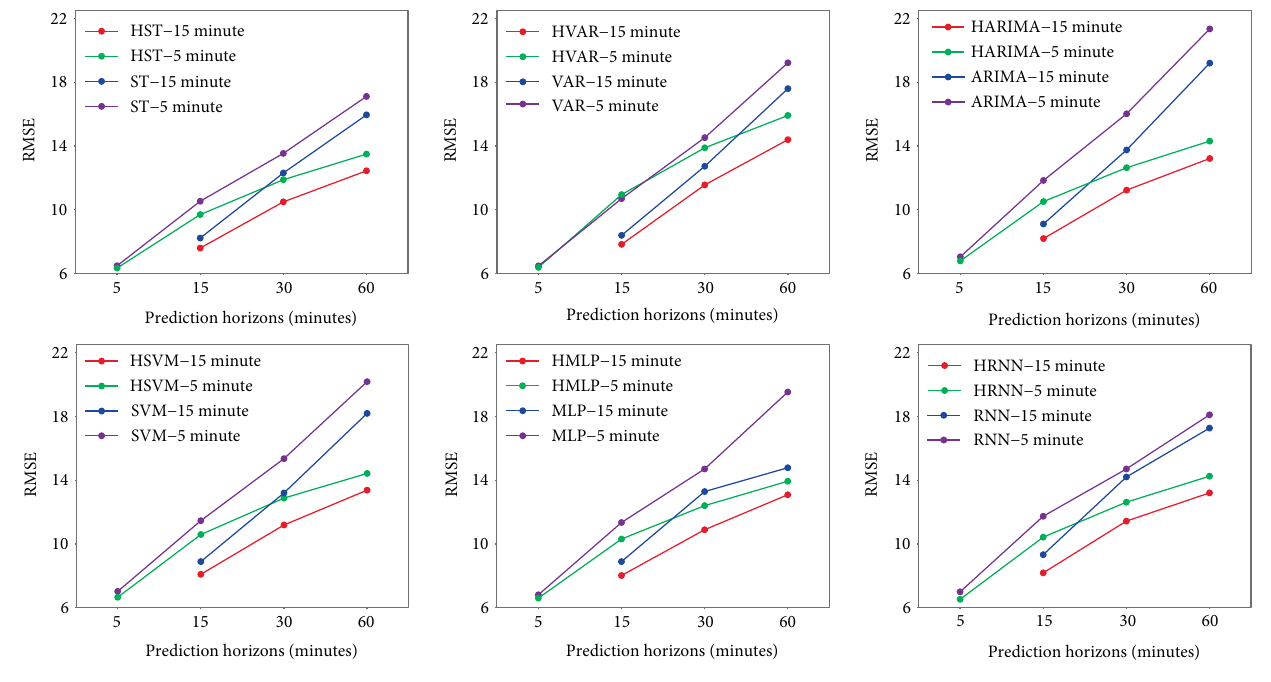
Figure 8: The RMSE values of models for different horizons and aggregation levels in peak hours on station